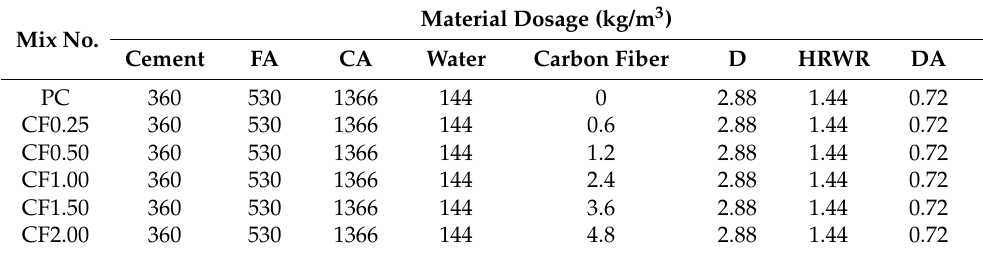
Table 2. Variation of mix